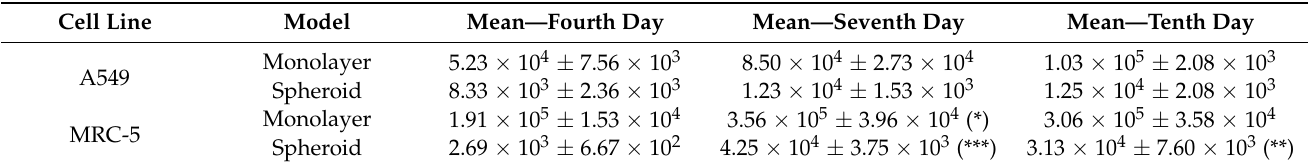
Table 3. Cell quantification results for both the monolayer and three-dimensional models using the trypan blue method.